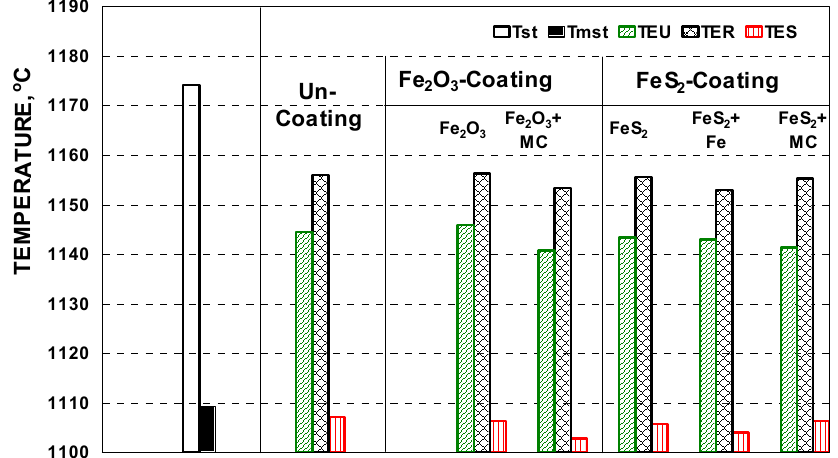
Figure 4. The lowest (TEU) and the highest (TER) temperatures during eutectic reaction and at the end of solidification (TES) for uncoated and different inner coated ceramic cups, compared to stable (T st ) and metastable (T mst ) equilibrium eutectic temperatures.